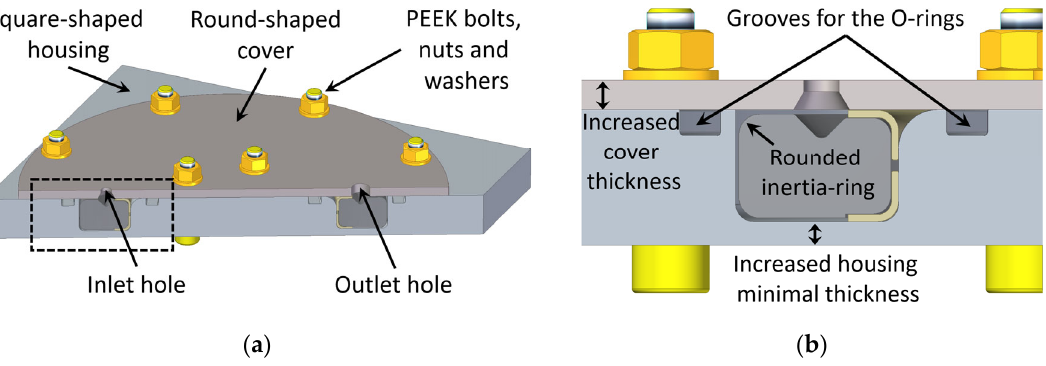
Figure 5. CAD model of the test damper. ( a ) Section view; ( b ) Detail view at the inlet hole.